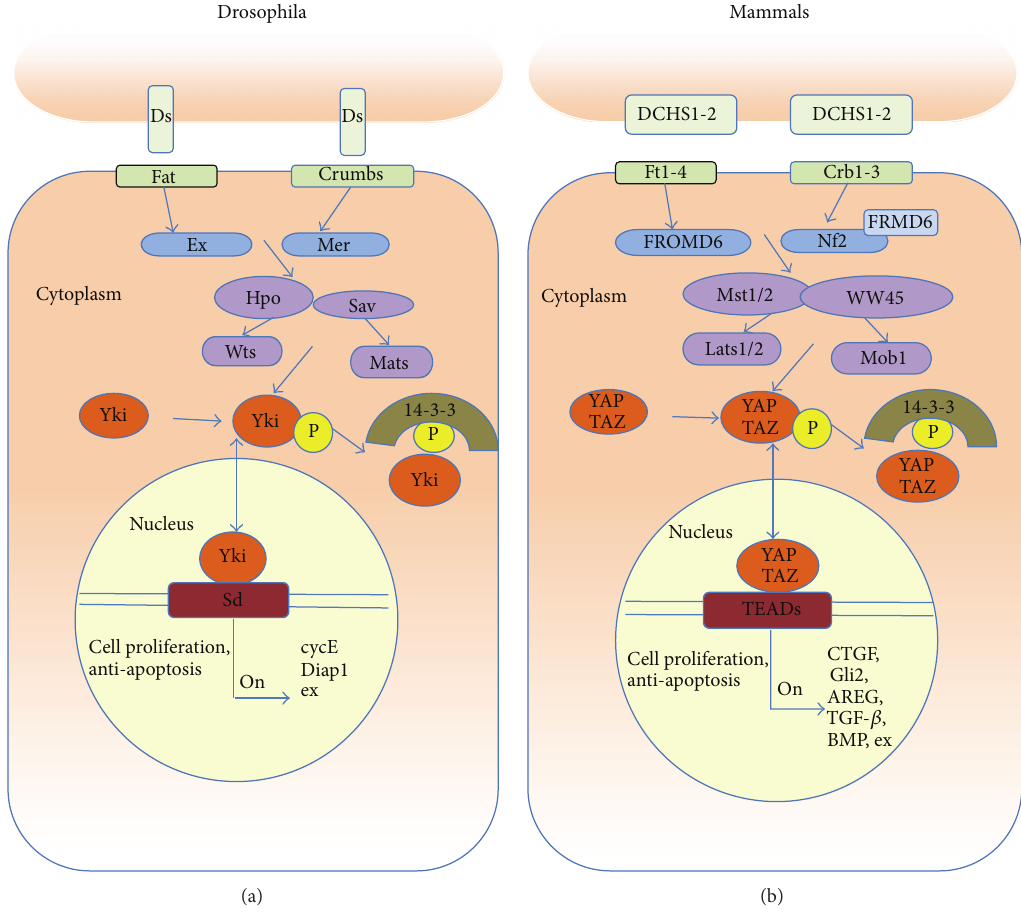
Figure 1: The Hippo pathway in Drosophila (a) and mammals (b). In the Drosophila, the upstream regulation factors exist in both surface membrane, such as Ds, Fat, and Crumbs, and submembrane proteins, such as Ex and Mer. The main effectors of Hippo pathway upstream are Hpo, Sav, Wts, and Mats, and the downstream effectors are Yki and Sd. In the mammals, the homologies of Drosophila in surface membrane protein are DCHS1-2, Ft1-4, and Crb1-3. The submembrane regulators are Nf2 and FROMD6. The Hippo pathway core machinery consists of Mst1/2, WW45, Lats1/2, and Mob1 and downstream effectors are YAP, TAZ, and TEADs. When surface membrane proteins are activated, they will activate subsequence effectors, which will then recruit Hippo core effectors to form complex, such as FRMD6-Nf2 and YAP-TAZ (Yki in Drosophila). Activated Hippo kinase complex will phosphorylate and then be inactivated through interaction with 14-3-3 proteins. Nonphosphorylated YAP/TAZ transfer into the nucleus, interact with TEADs (Sd in Drosophila), and then drive target gene expression to promote cell proliferation and suppress